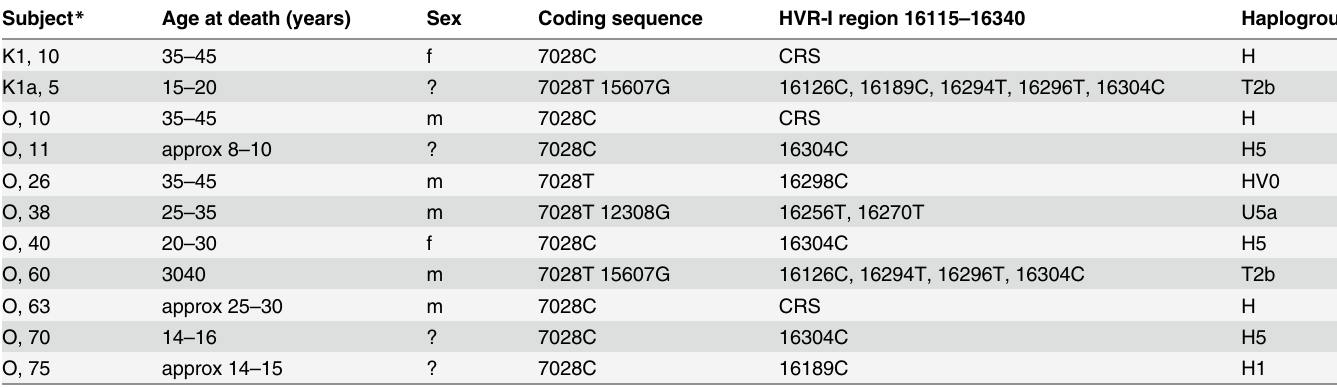
Table 1. Summary of the genotyping data in the analyzed mtDNA sample of the